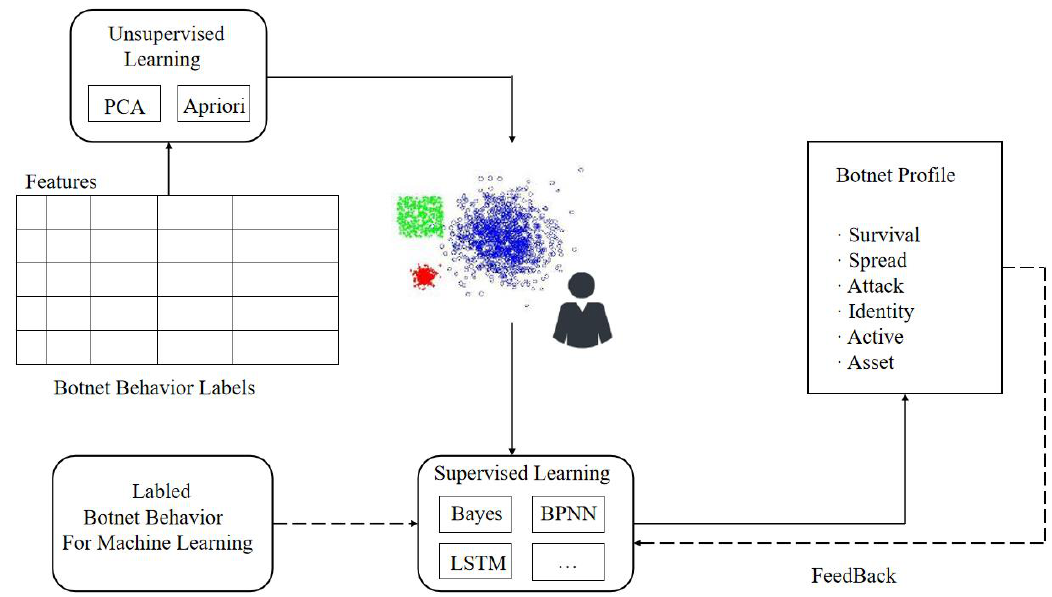
Figure 5. Process of Android malware behavioral portrait.